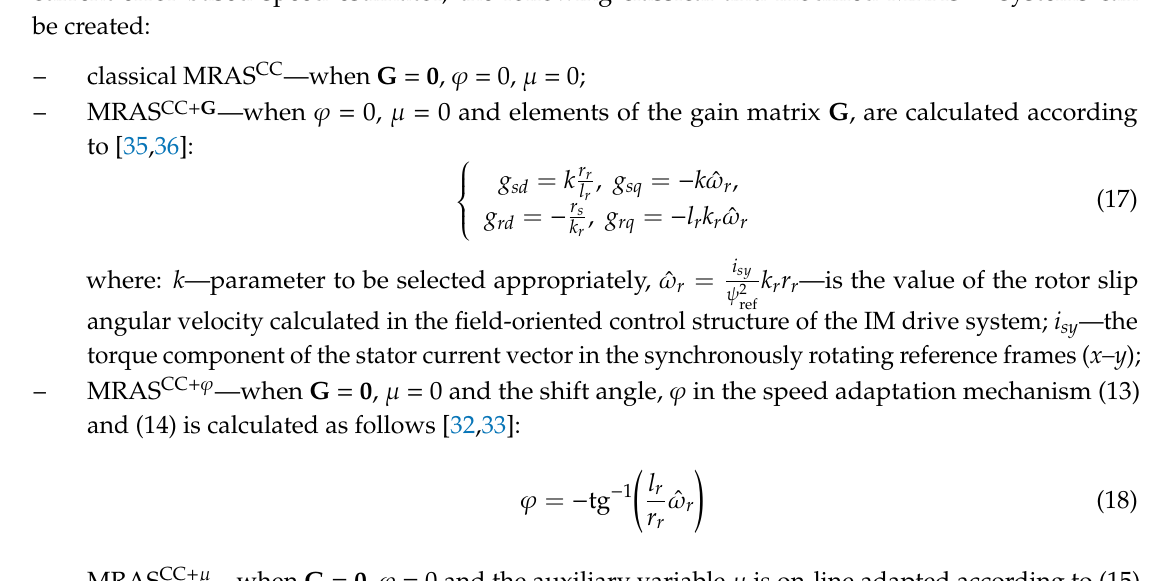
Figure 2. General block diagram of the MRAS CC with all stability improvement methods.